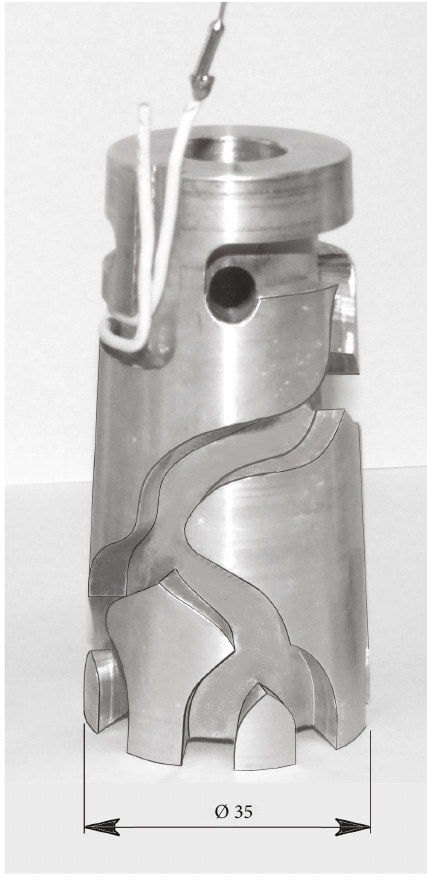
Figure 9: Photograph of the middle cone with the grooves according to Figure 7. Note the 6mm dia hole near the top of this component. It leads to the inner cone shown in Figure 10.